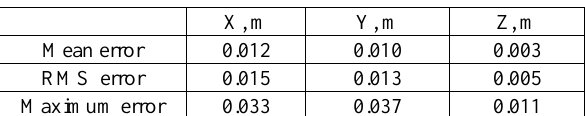
Table 3. Relative accuracy estimation of MLS data adjustment using check points